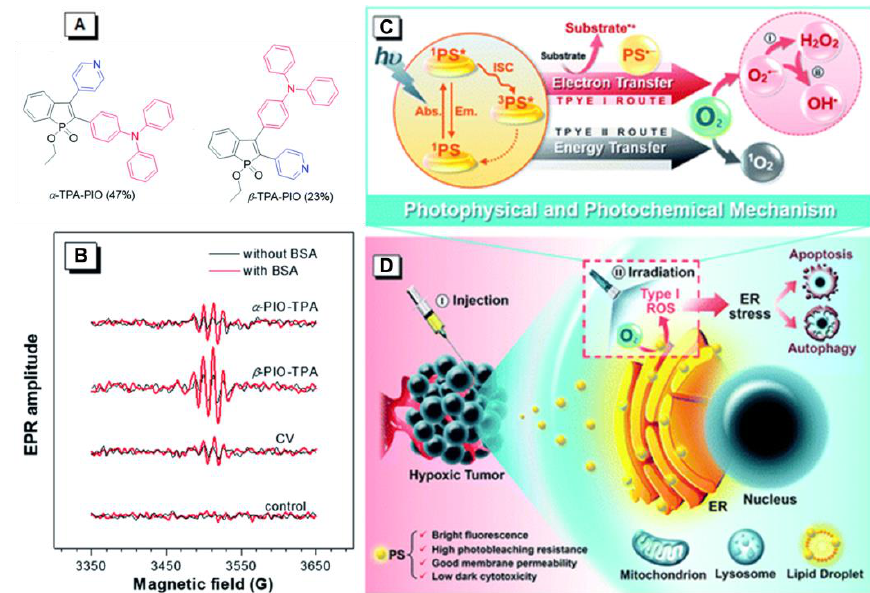
Figure 4. ( A ) Chemical structures of α -TPA-PIO and β -TPA-PIO. ( B ) Electron paramagnetic resonance (EPR) signals of BMPO (for Type I ROS detection) in the presence of 1 mM α -TPA-PIO, β -TPA-PIO or CV (without/with 500 nM BSA) in PBS with 1 vol % DMSO. Schematic illustration of ( C ) photophysical and photochemical mechanisms and ( D ) the cytological process of photodynamic therapy (PDT) treatment mediated by phosphindole oxide based fluorogens. (i) Disproportionation reaction; (ii) Haber – Weiss/Fenton reaction. Adapted and modified with permission from reference 44 (open access 2020, Royal Society of Chemistry).